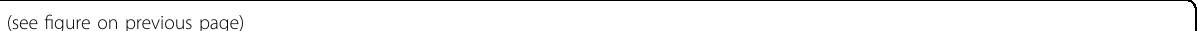
Fig. 1 Dissection of immune dynamics during immunization with scRNA-seq. a Work fl ow of PBMCs collection, processing, sequencing, data analysis, and antibody validation. Cells from four participants at three timepoints were subjected to scRNA-seq and scV(D)J-seq. Antigen-speci fi c antibodies were predicted and screened based on the CDR3 sequence from scBCR-seq. PBMCs, peripheral blood mononuclear cells. b t -SNE projection of canonical markers of each cell type. Cells are annotated based on differential expression analysis on orthogonally discovered clusters. c Heatmap revealing the scaled expression of DEGs for B cells, NK and T cells, and myeloid cells. d ScRNA-seq visualization with t -SNE analysis of PBMCs ( n = 92,456) from all participants and timepoints sampled (top), and t -SNE annotated by timepoints and colored by individuals (bottom). e Proportions of major cell types from each participant at different timepoints assayed in this study. f Proportions of different cell types in the total PBMCs from participants at different timepoints by